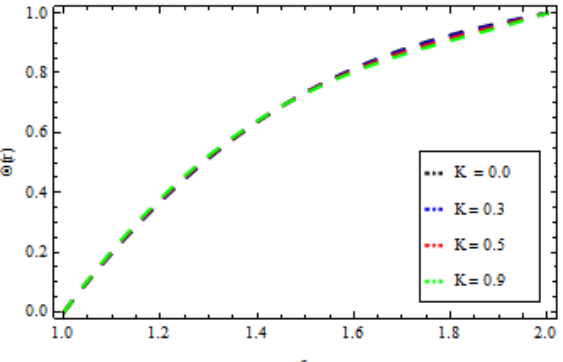
Figure 9. Temperature profile for various values of K when δ = 2, β = 0.2, M = 0.2, Br = 1.